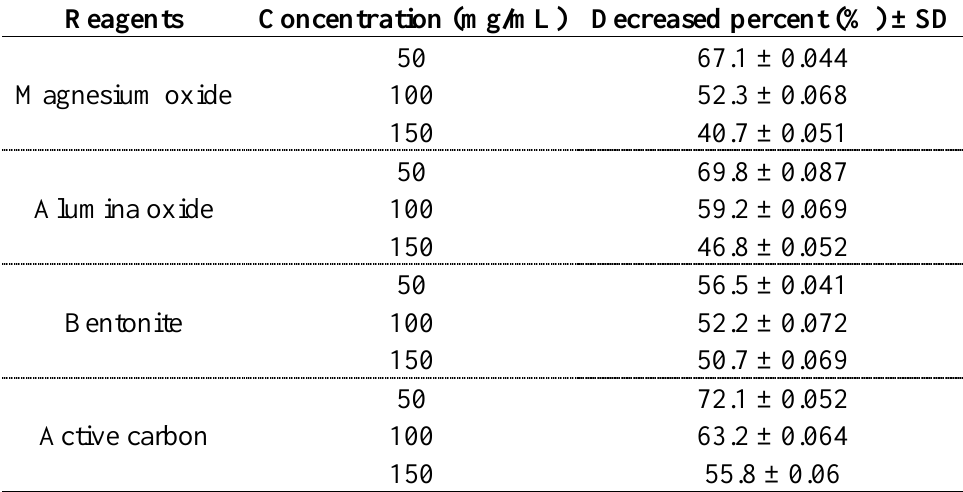
Table 1. Decreased chlorophyll content against several